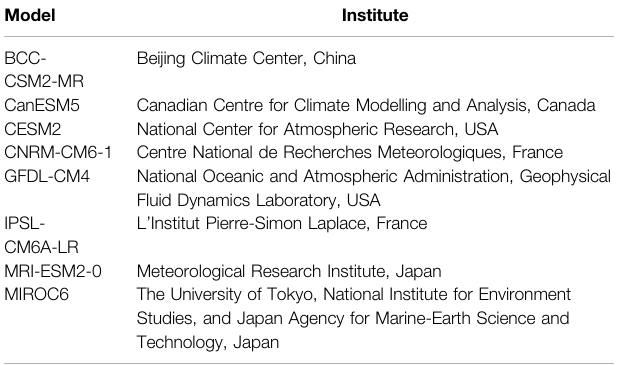
TABLE 1 | AMIP models from CMIP6 used in this study. Model